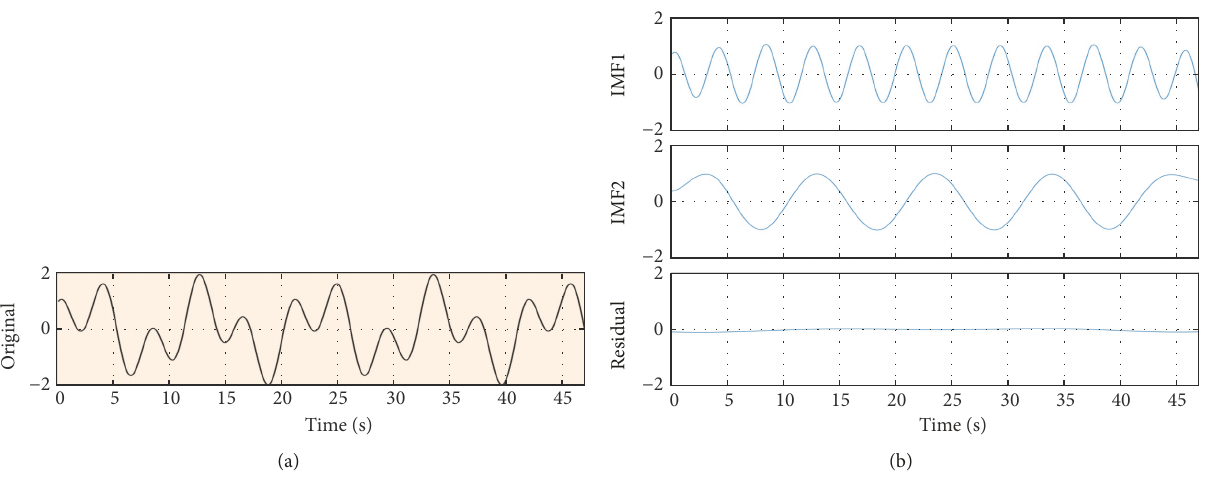
Figure 3: Demonstration of a decomposition using 1D EMD. (a) The synthetic signal, (b) first IMF, (c) second IMF, (d) residual.